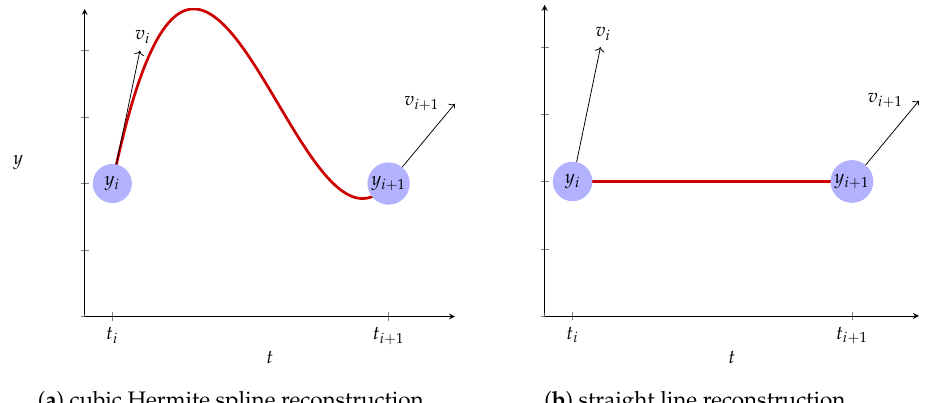
Figure 1. Comparing cubic Hermite spline reconstruction and straight line reconstruction. When ∆ T = t − t i i + 1 i is large or ¯ v i